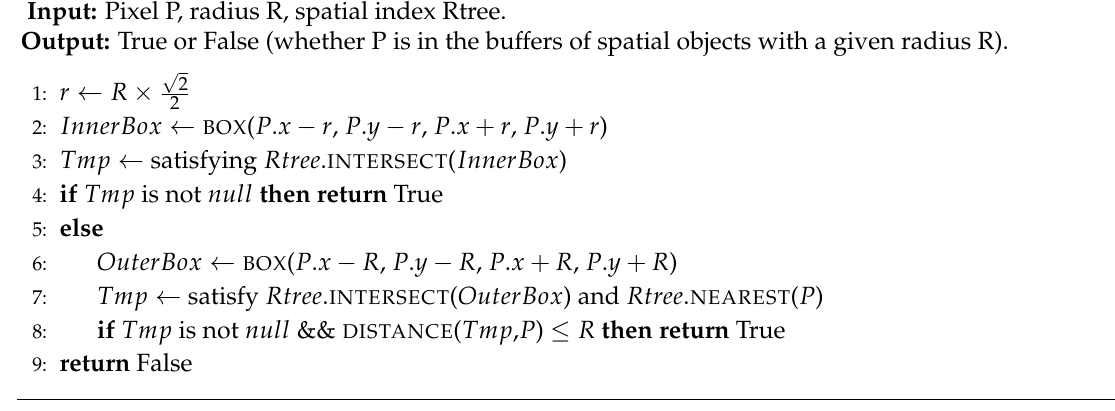
Algorithm 1 SIBBG for point and linestring objects [21]